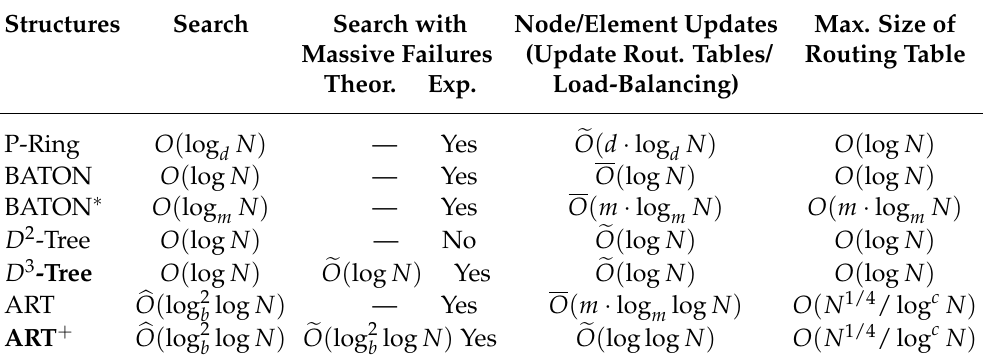
Table 1. Comparison of P-Ring, BATON, BATON ∗ , D 2 -Tree, D 3 -Tree, ART and ART + . Structures Search Search with Node/Element Updates Max. Size of Massive Failures (Update Rout. Tables/ Routing Table Theor.